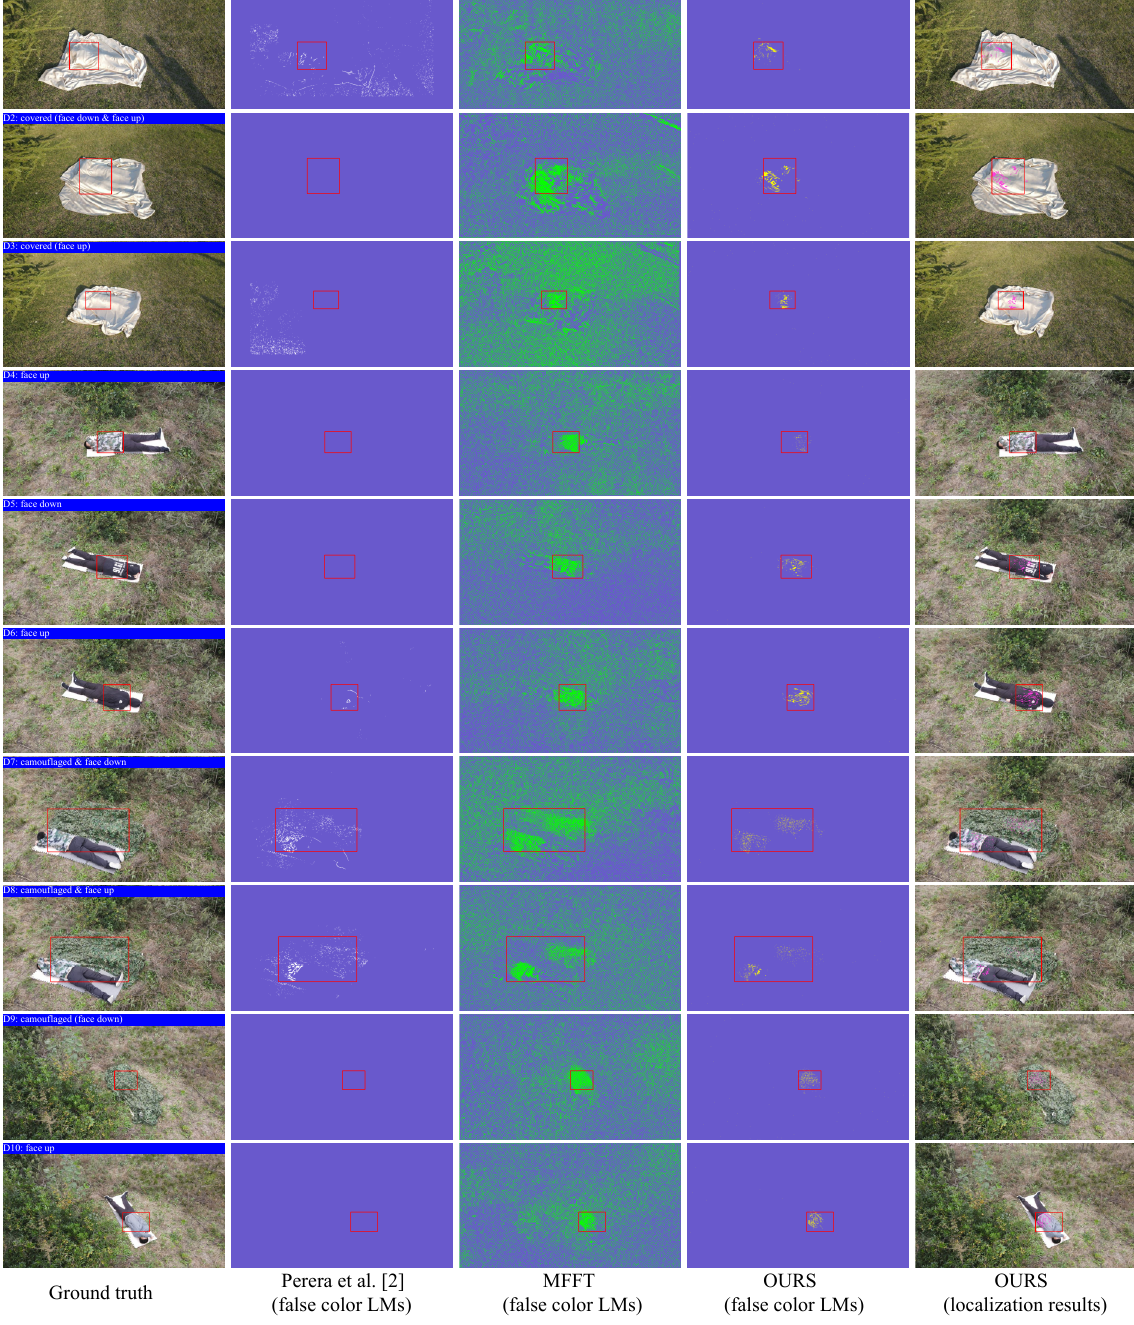
Figure 6. False color location maps (LMs) of Perera et al.’ work [2], MFFT and ours, and our localization results for ten drone